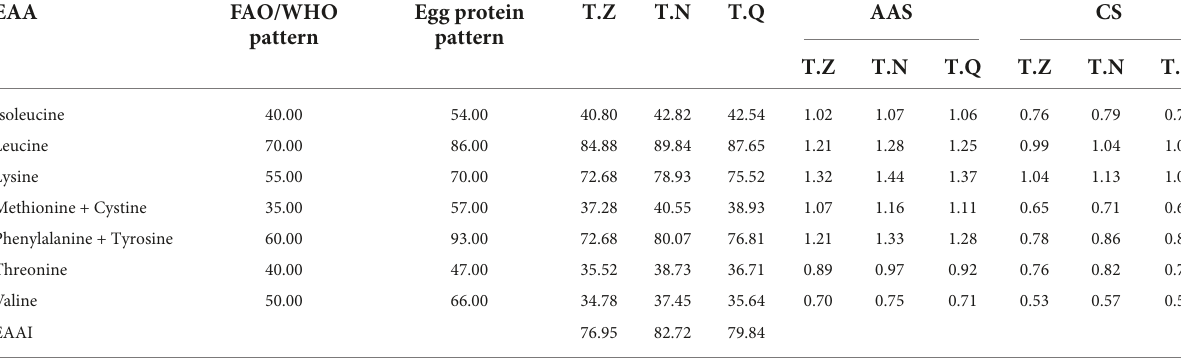
TABLE 4 Essential amino acid content, AAS, CS, and EAAI in hairtail muscle (mg · (g · pro) − 1 ).